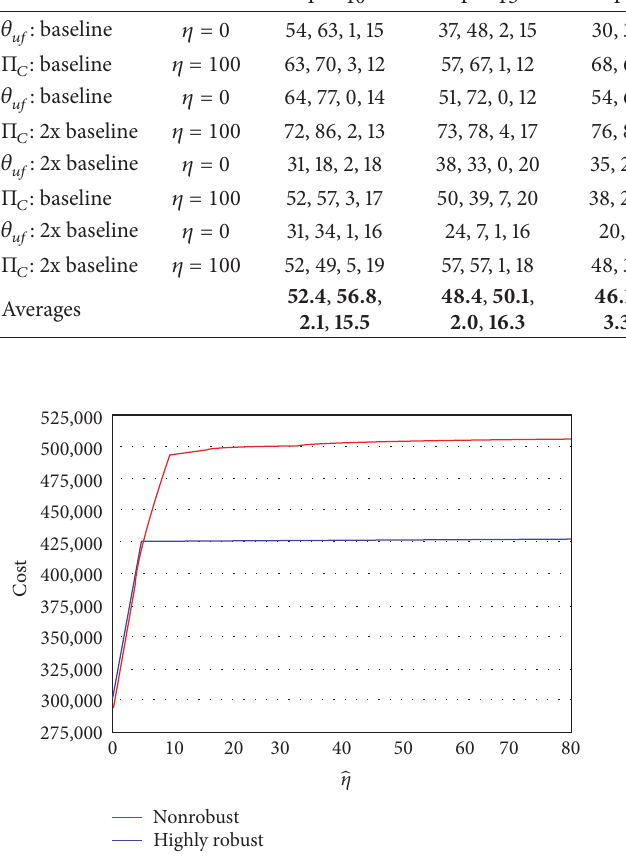
Figure 9: Range of potential cost values for nonrobust and highly robust solutions, maximum transport distance of 0.25